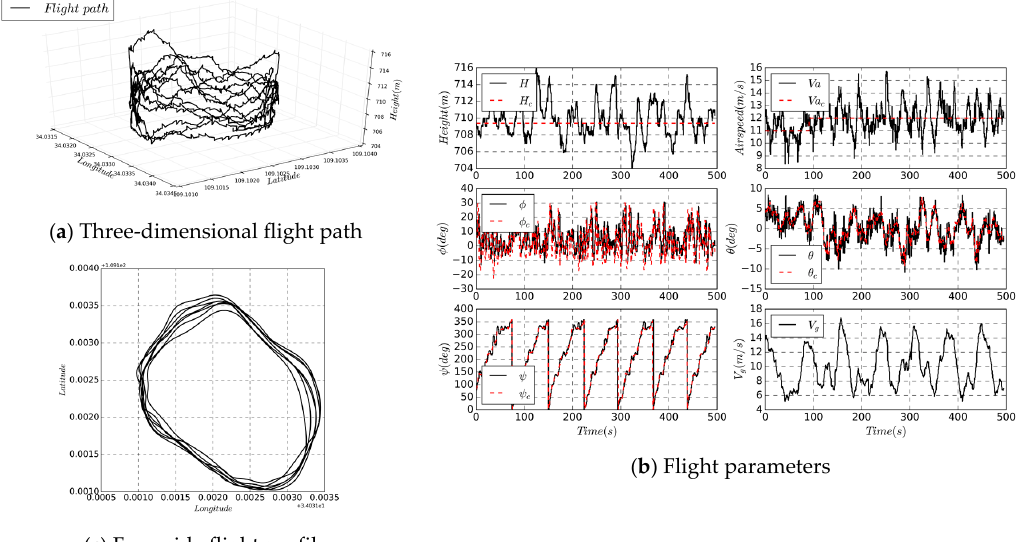
Figure 15. Flight path and state parameters during cruise process.